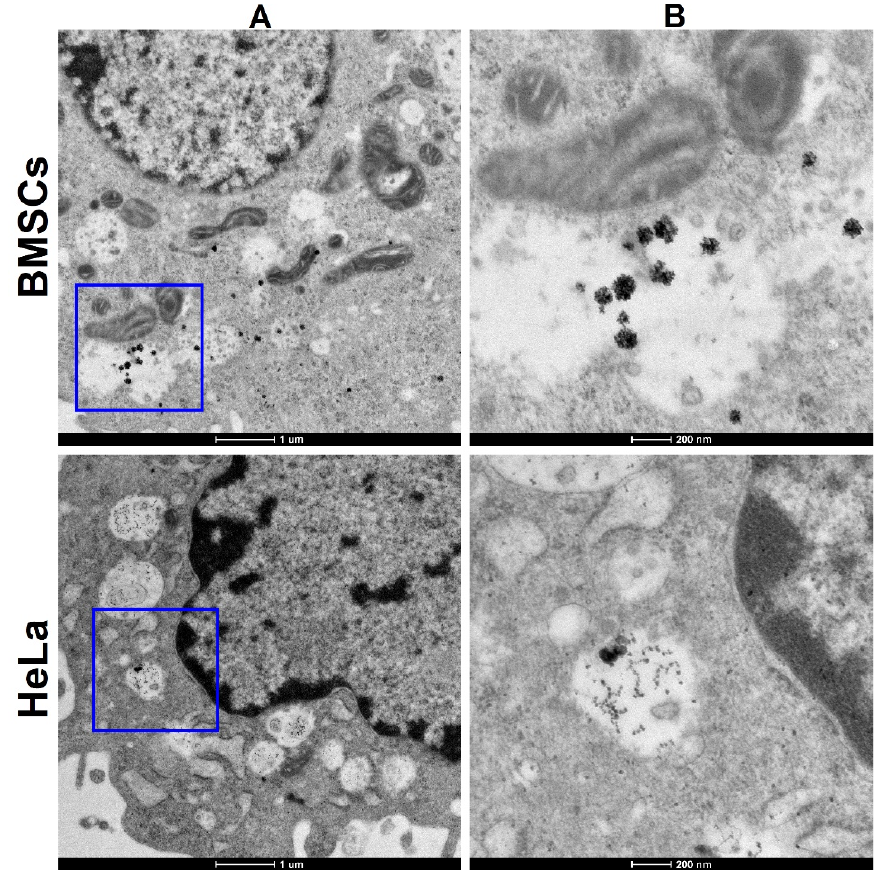
Figure 9. TEM images indicating internalization of Au NPs within BMSCs and HeLa cells. Enlarged images of the highlighted regions in column A are shown in column B. Scale bars: 1 µm ( A ) and 200 nm ( B ).